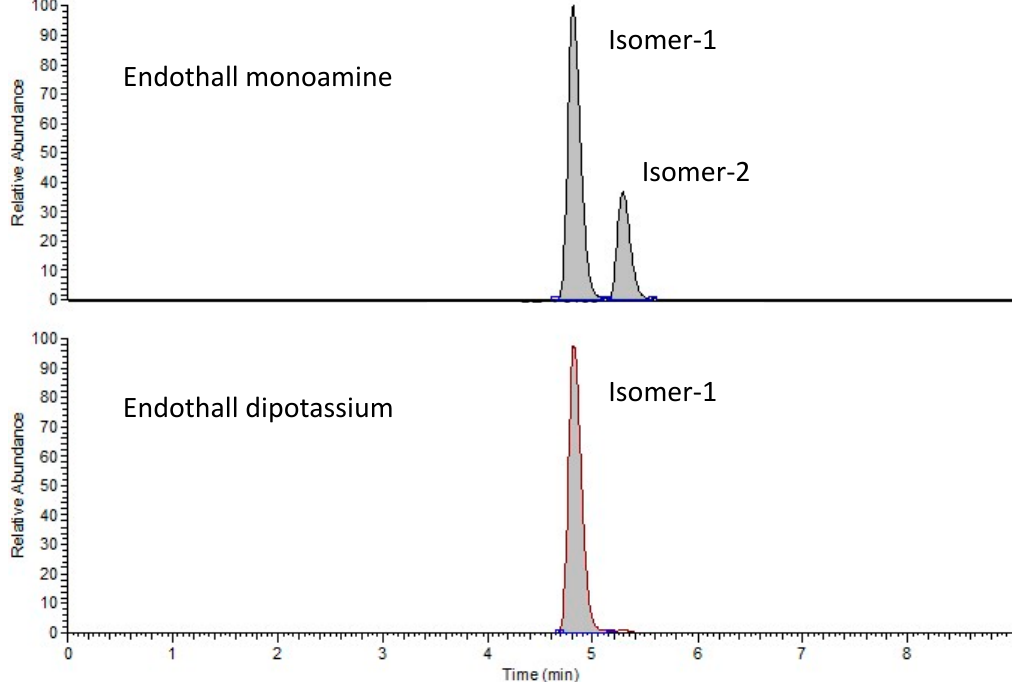
Figure 1. Extracted ion chromatogram of endothall, in two formulations. Endothall concentrations of isomer-1 are 10 mg L − 1 in both cases.